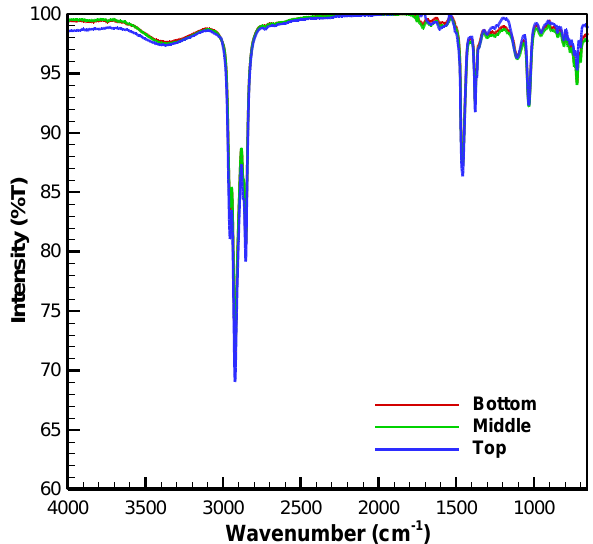
Figure 9. FTIR spectra of the emulsion with 2 g bio-oil, B/E = 1, and 1 g methanol for 7 days.